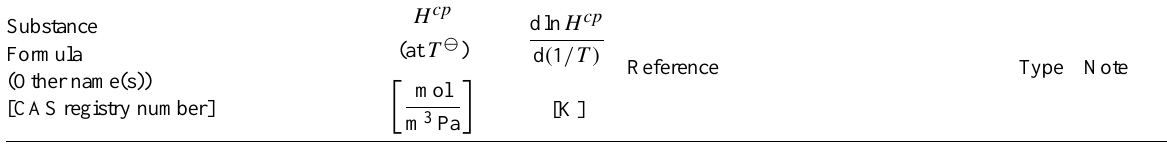
Table 6: Henry’s law constants for water as